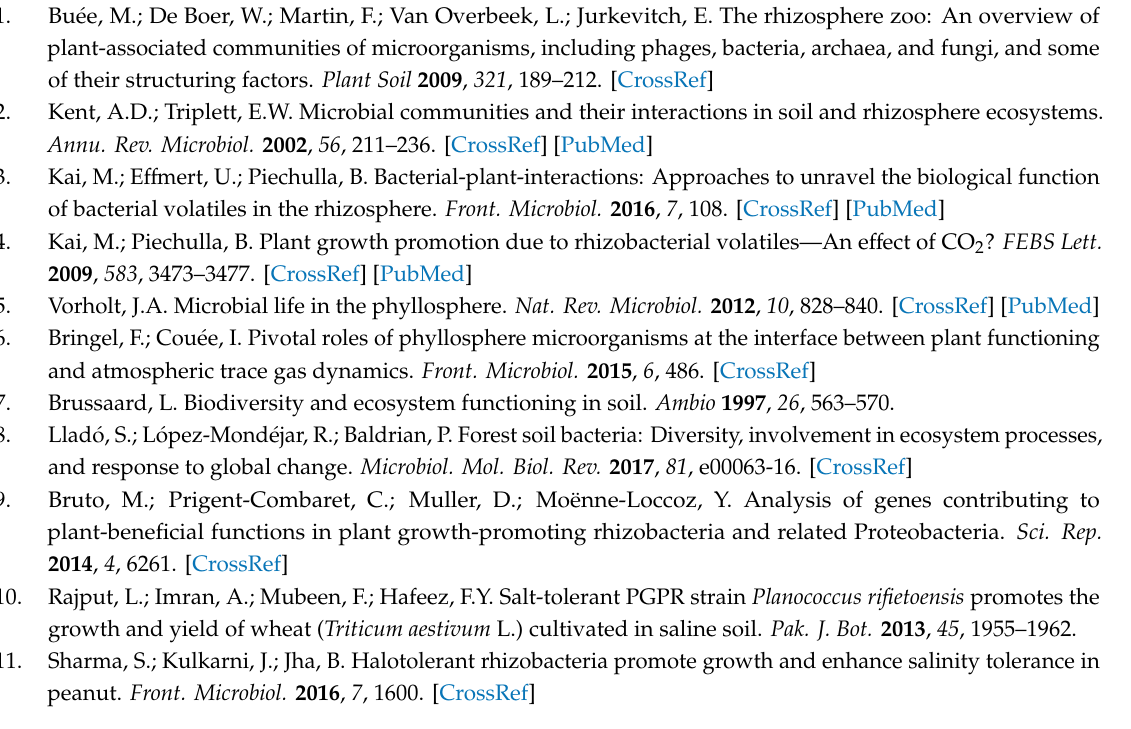
Figure S1: Sampling locations of tomato plants from two di ff erent locations in Santorini Island (Vlichada and Emporio), of aromatic plants from the forest of Seich-Sou and of halophytes from the National Park of Delta Axios. Figure S2: Rarefaction curves representing the number of OTUs against the number of high-quality reads after rarefication and removal of ambiguous reads. Table S1: Number of OTUs, the richness estimator (S Chao1 ), the ratio observed / expected OTUs and the heterogeneity of the alpha-diversity indexes (the Simpson dominance and Equitability indexes) and the total number of reads in each sample. The total and average number of OTUs, number of reads and average values of the alpha diversity estimators are also shown. N / A: Not